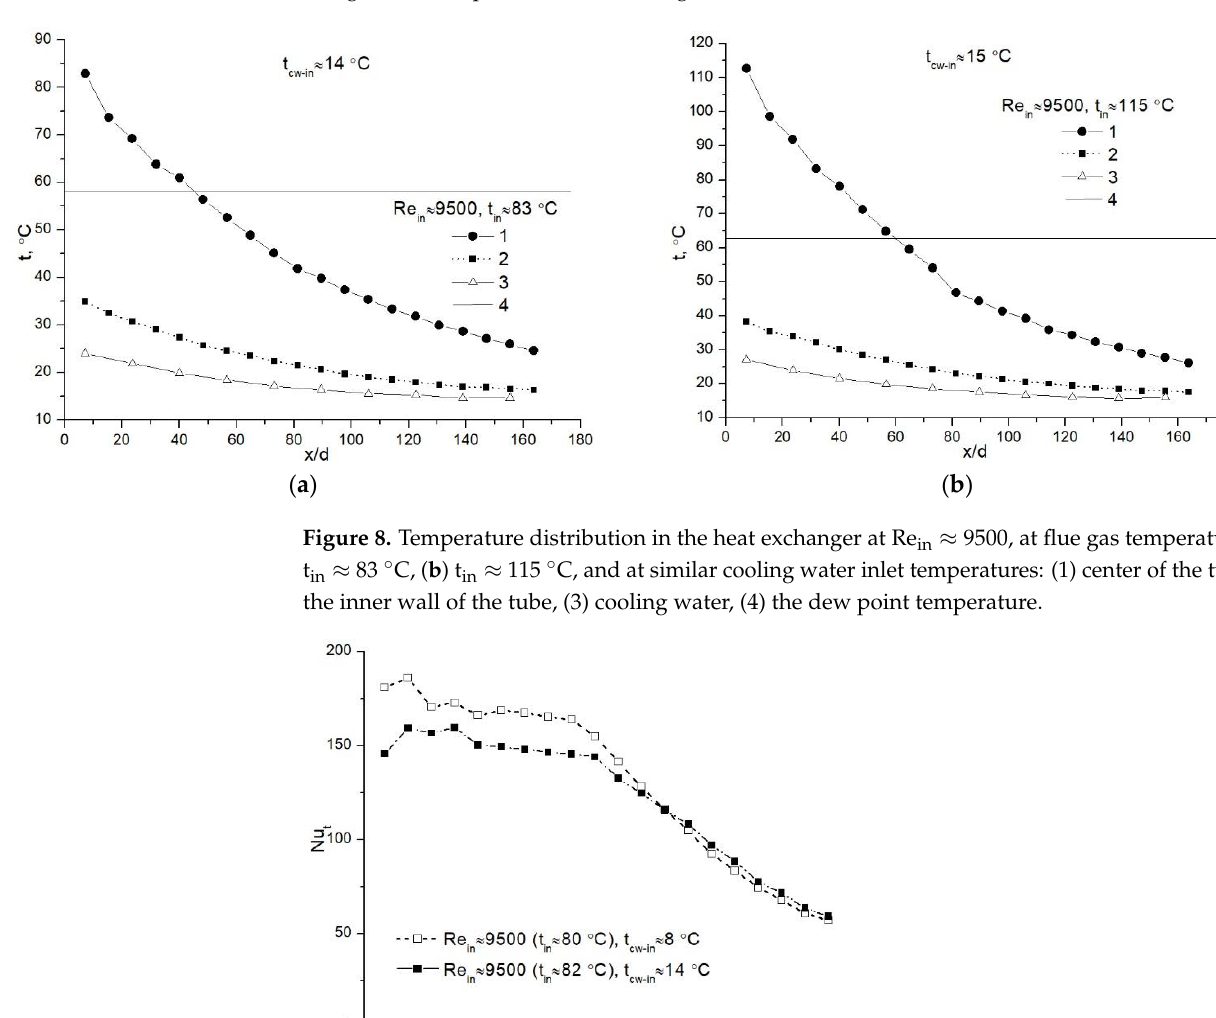
Figure 9. Distribution of the local Nu t in the heat exchanger at Re in ≈ 9500 and at different cooling water inlet temperatures.